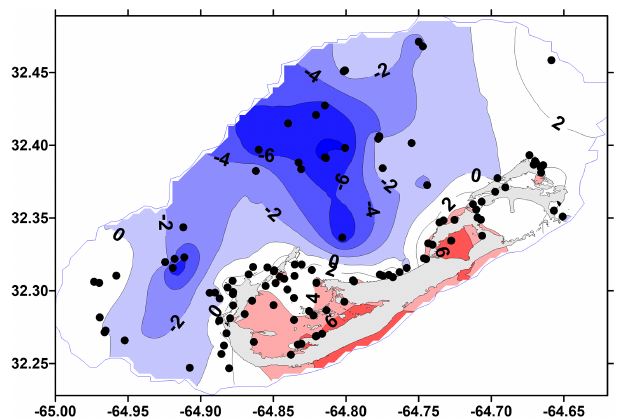
Figure 6. δ 15 N of seagrass leaves from the Bermuda Platform. Black dots indicate sites where at least one of the seagrasses Sy- ringodium filiforme , Thalassia testudinum or Halodule sp. occur. If more than one species occurred at a site, the average value for all co-occurring species is